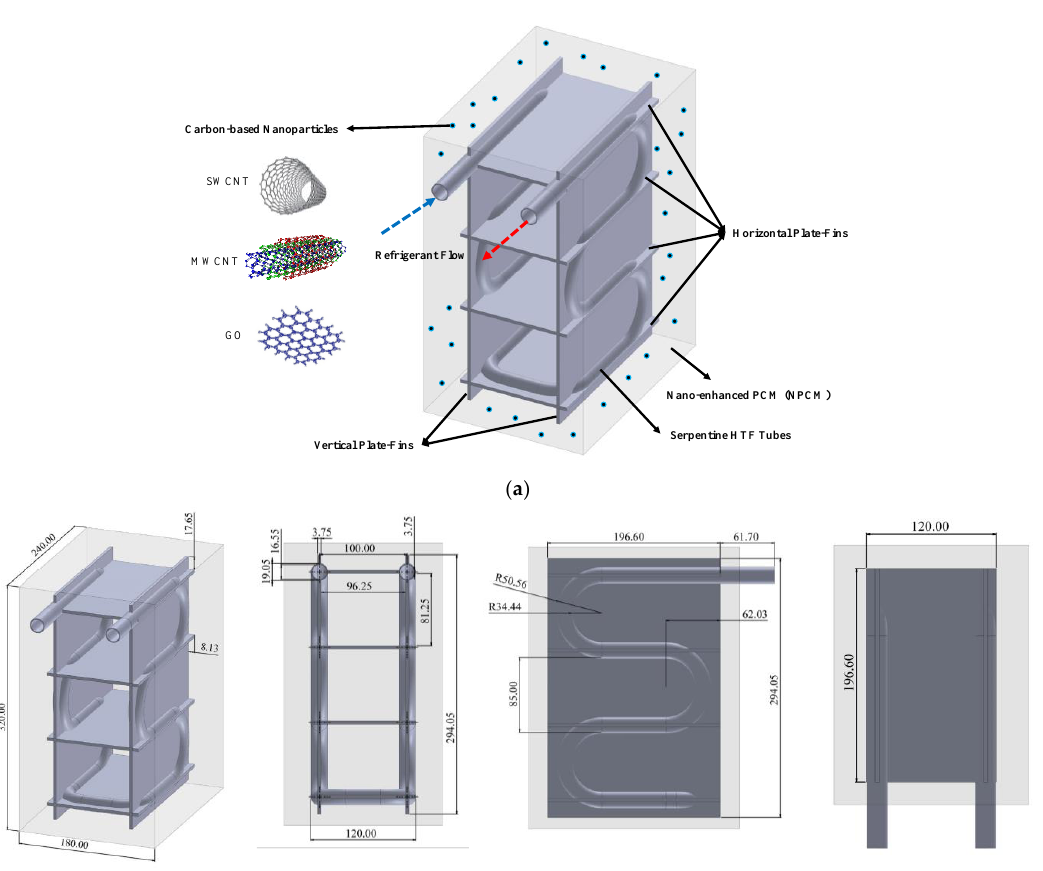
Figure 2. The CES container: ( a ) the physical representation; ( b ) complete geometric sizes.